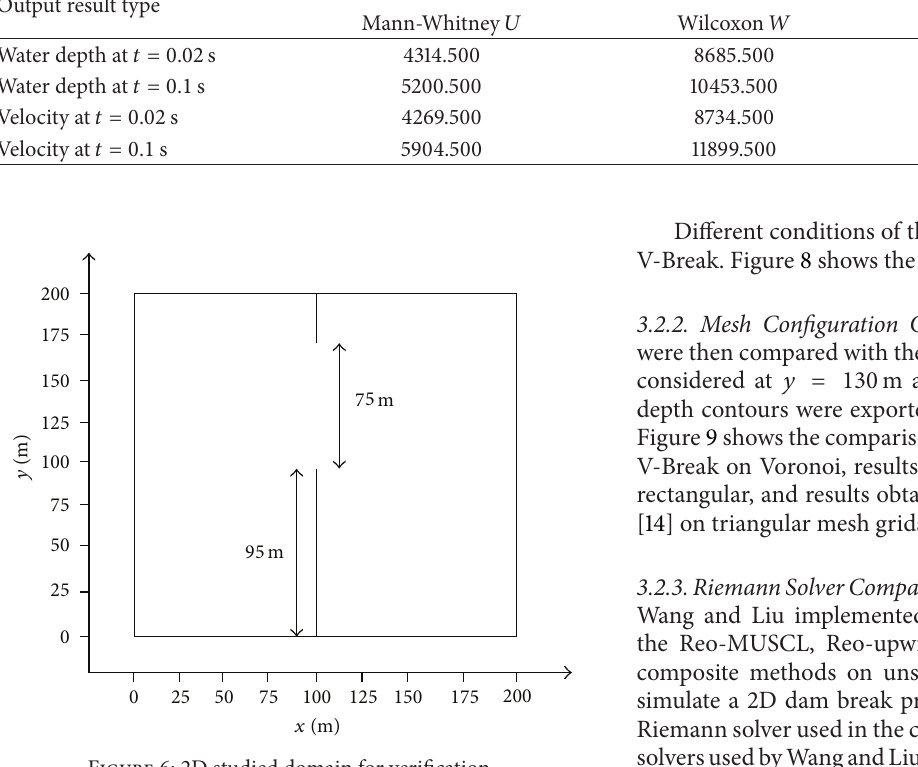
Figure 6: 2D studied domain for